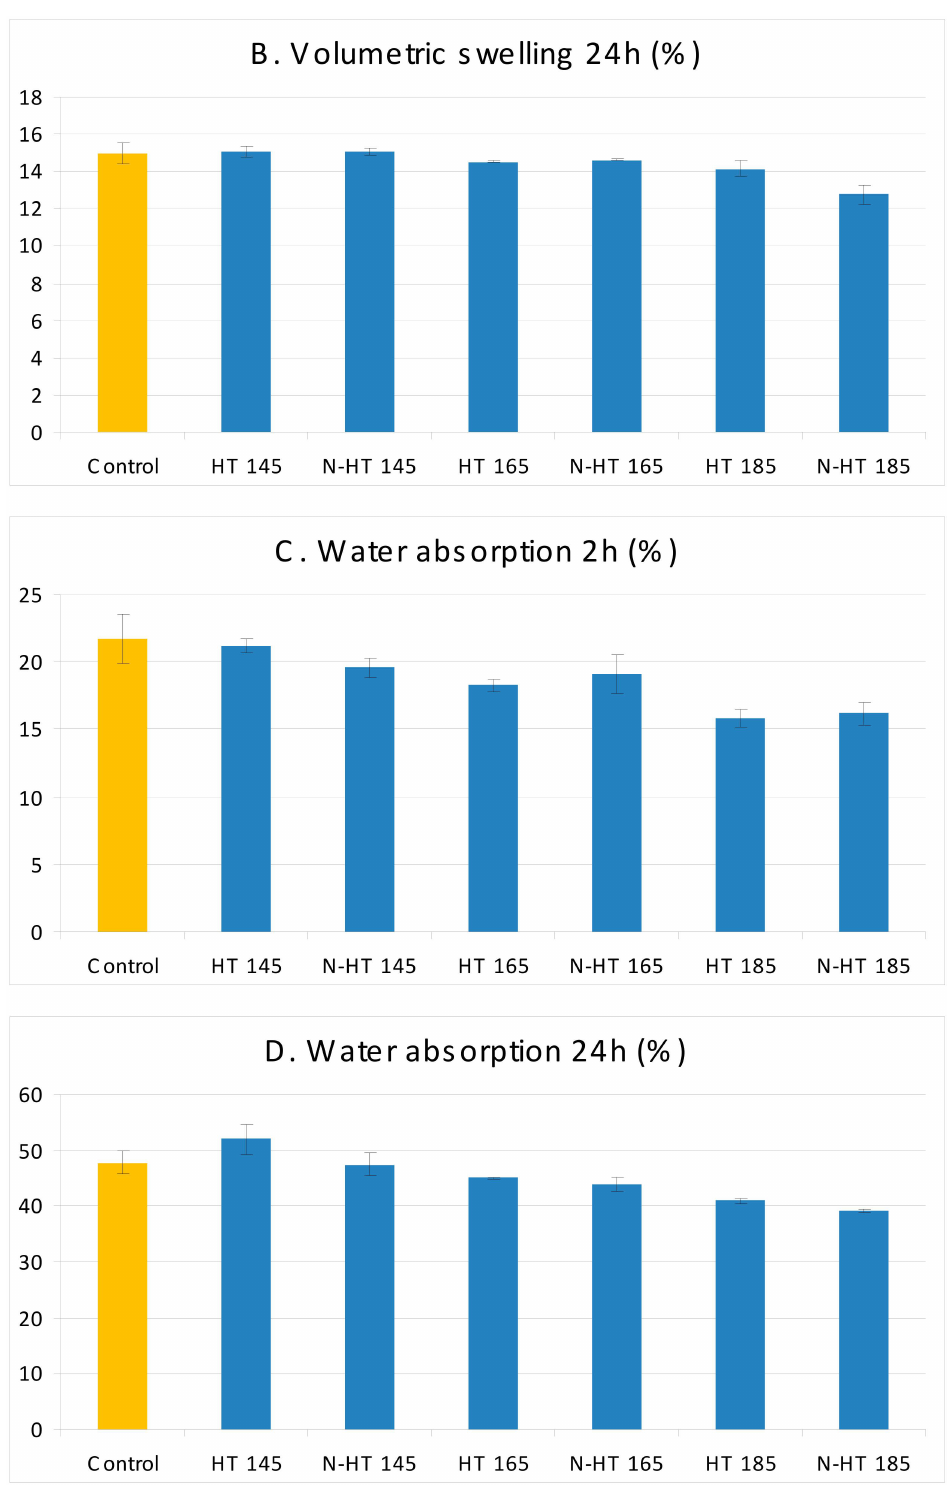
Figure 3. Physical properties in beech wood heat-treated at 145, 165, and 185 ◦ C and impregnated with silver nano-suspension (HT = heat treatment at a determined temperature; N = nanosilver